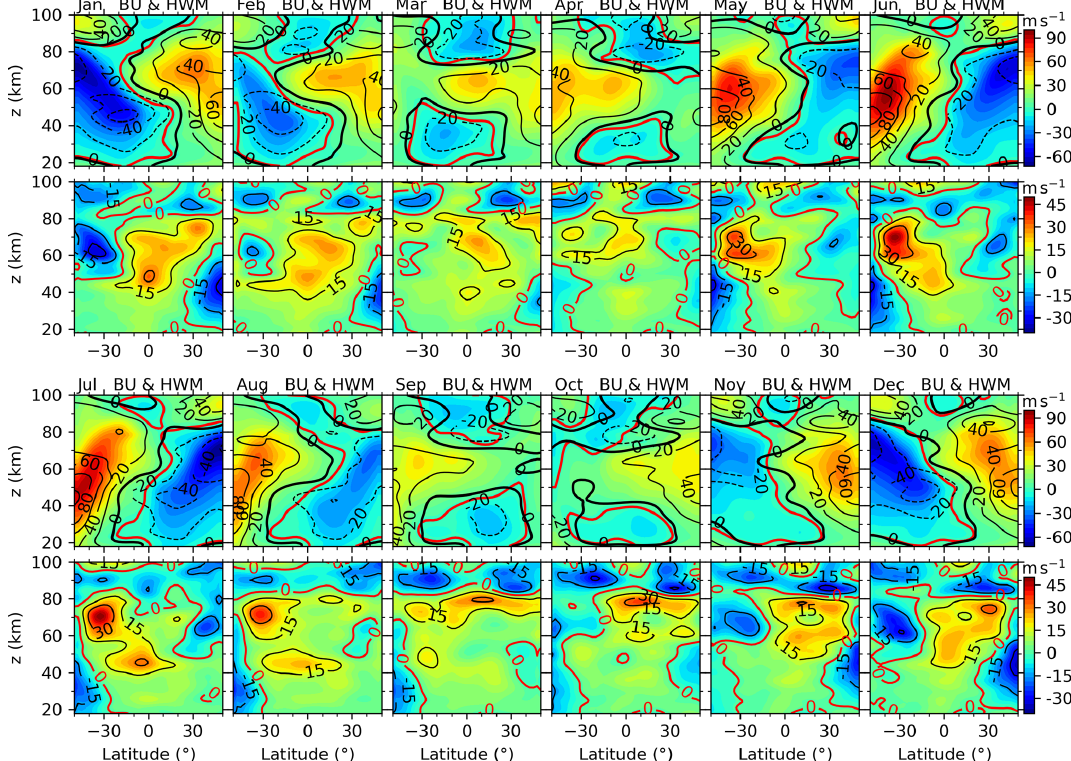
Figure 7. The same as Fig. 5 but for the BU and HWM14. The thick black and red contour lines are the zero wind of HwmU and BU,